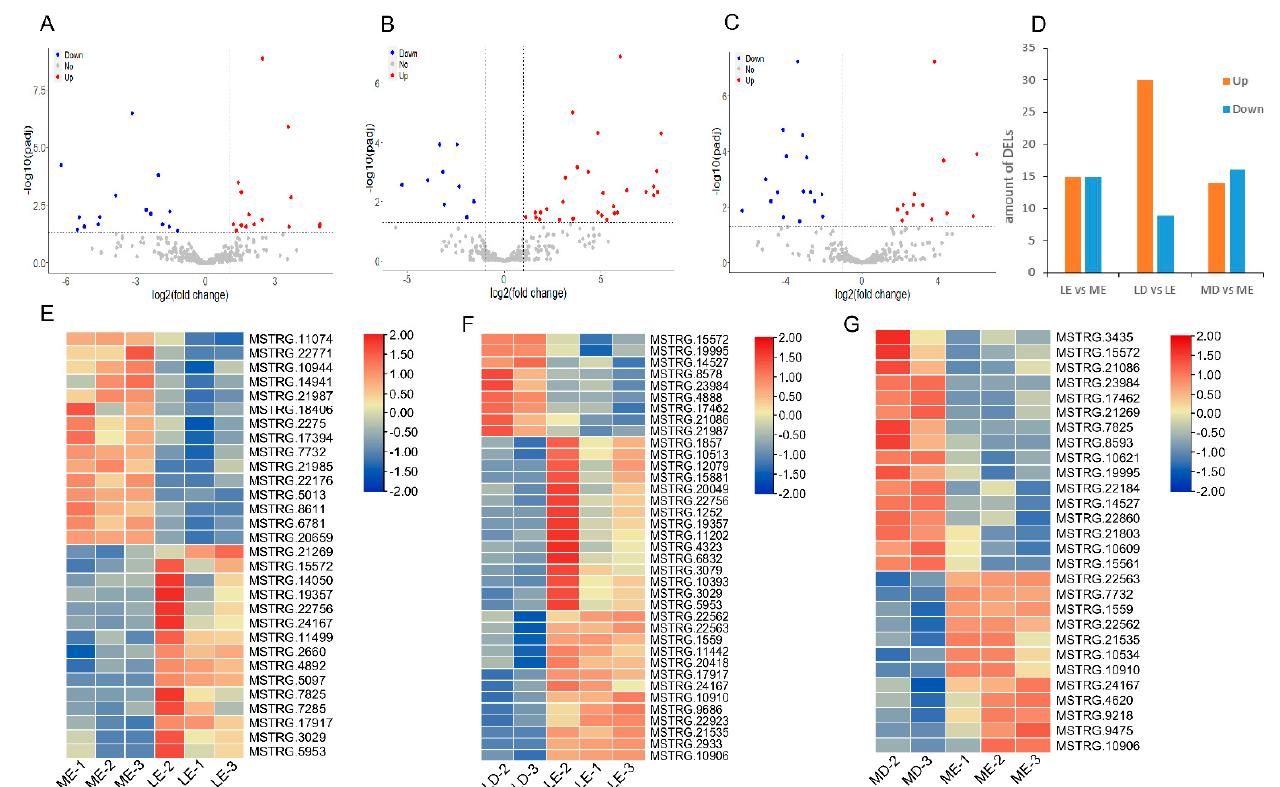
Figure 2. Analysis of differentially expressed lincRNAs. ( A – C ) Screening of the DELs between LE vs. ME, LD vs. LE, and MD vs. ME comparisons. ( D ) The number of DELs. ( E – G ) Hierarchical clustering heatmap of DELs. The color scale represents gene expression levels. Each row represents one gene, and each column represents one sample.